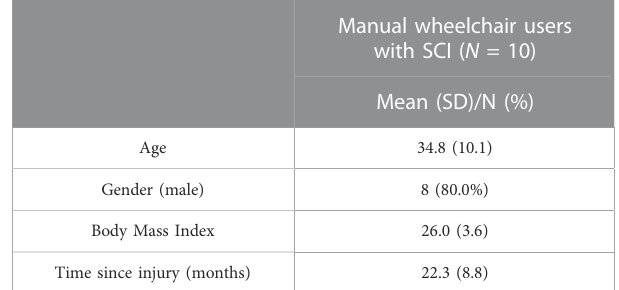
TABLE 1 Participant characteristics and